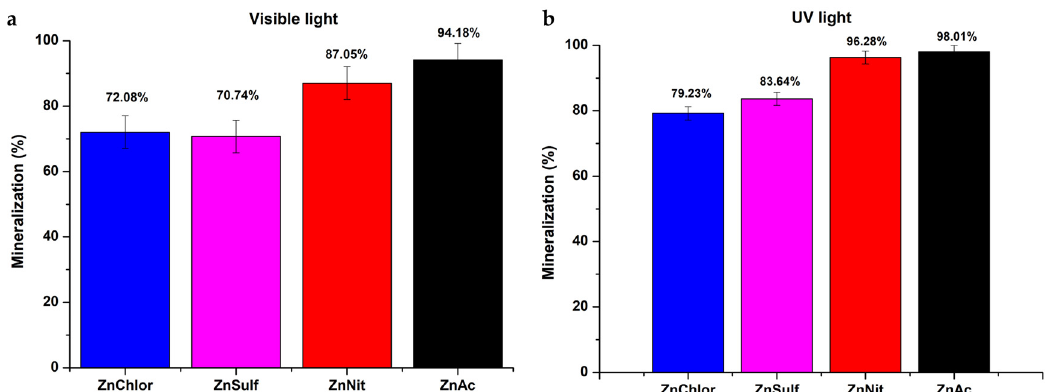
Figure 15. Mineralization (%) of each ZnO sample, obtained through TOC analysis, after the photo- catalytic procedure under ( a ) visible light and ( b ) UV light.